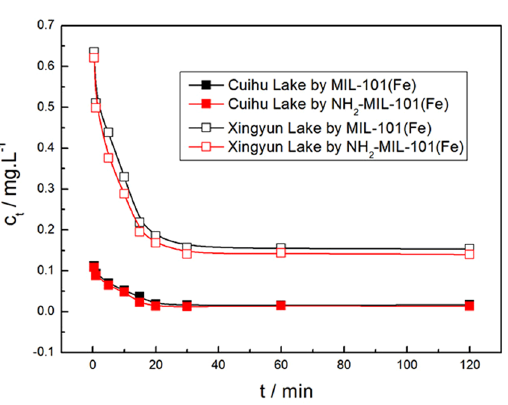
Figure 15. Adsorption of phosphate on MIL-101(Fe) and NH 2 - MIL-101(Fe) in two real eutrophic water samples (Cuihu Lake, c 0 = 0.265 mg·L − 1 ; Xingyun Lake, c 0 = 1.561 mg·L − 1 ; Adsorbents, 12 mg; V = 0.2 L; T = 293